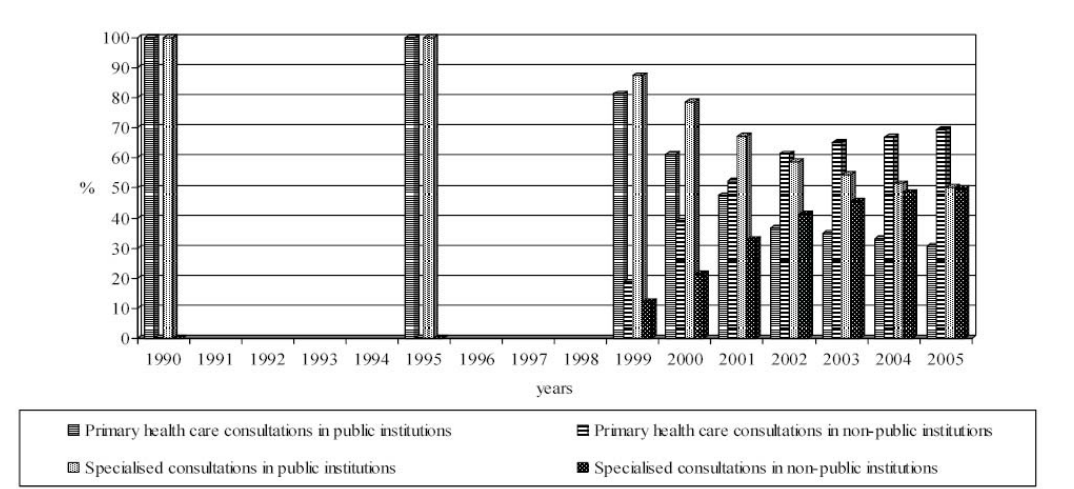
Fig. 3 Privatisation of primary health care and specialised